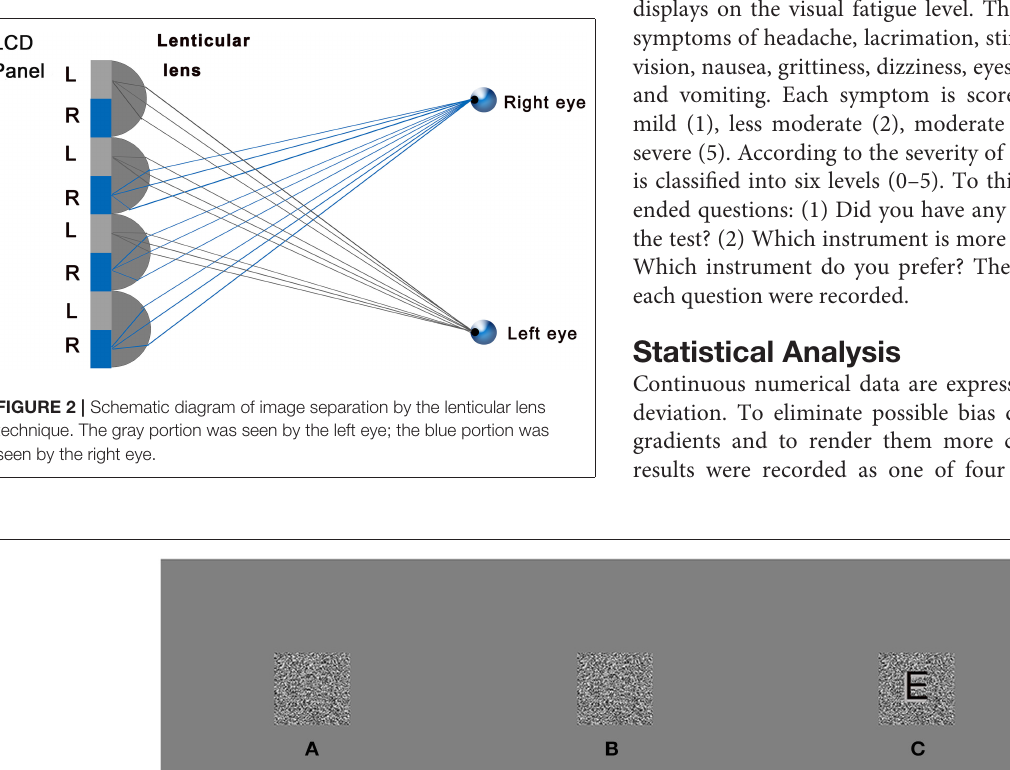
Frontiers in Medicine |